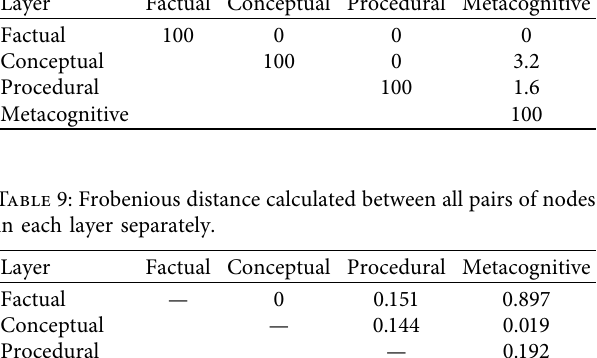
Table 7: The percentage overlapping of nodes in the MKN network.